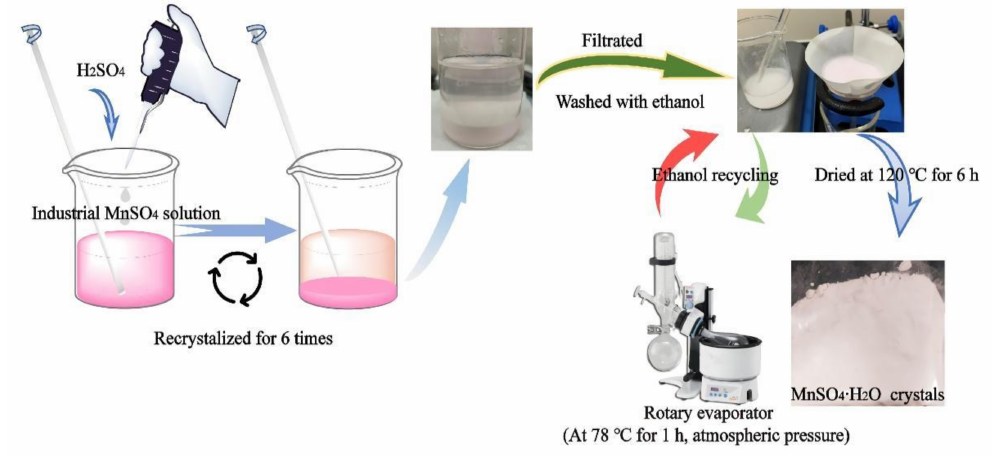
Figure 1. Preparation flow chart of MnSO 4 · H 2 O